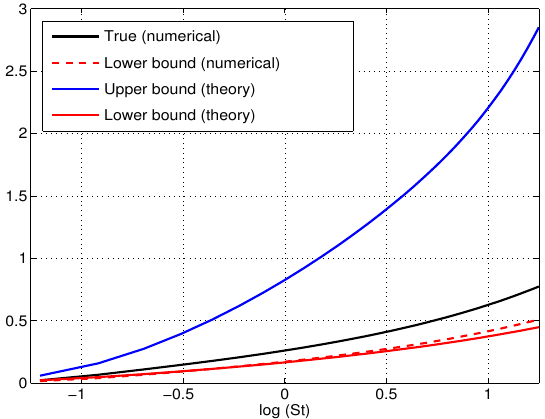
Figure 4. The theoretical upper and lower bounds for the caustic rate ν ( s ) as functions of Stokes number s and its numerical